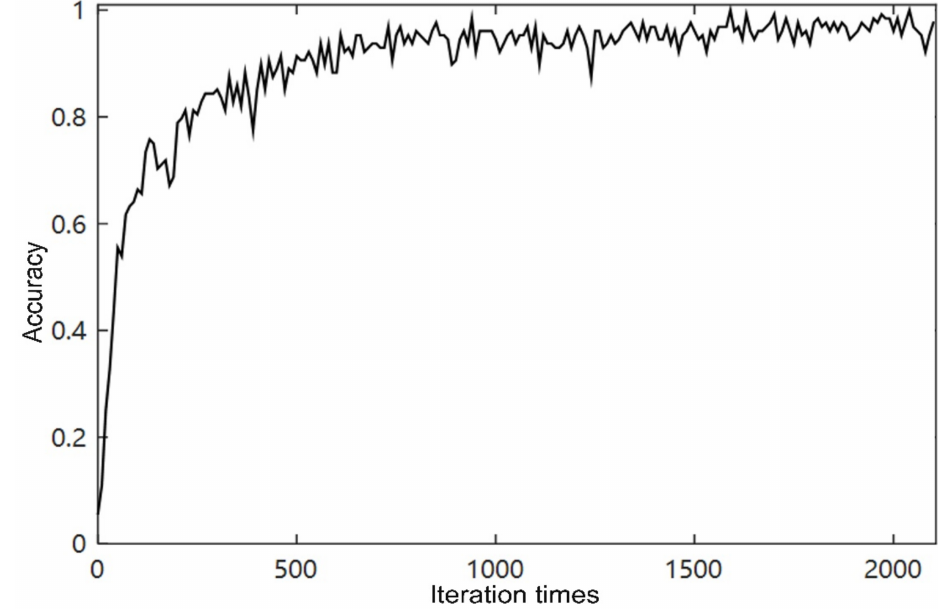
Figure 4. GRU circular neural network accuracy